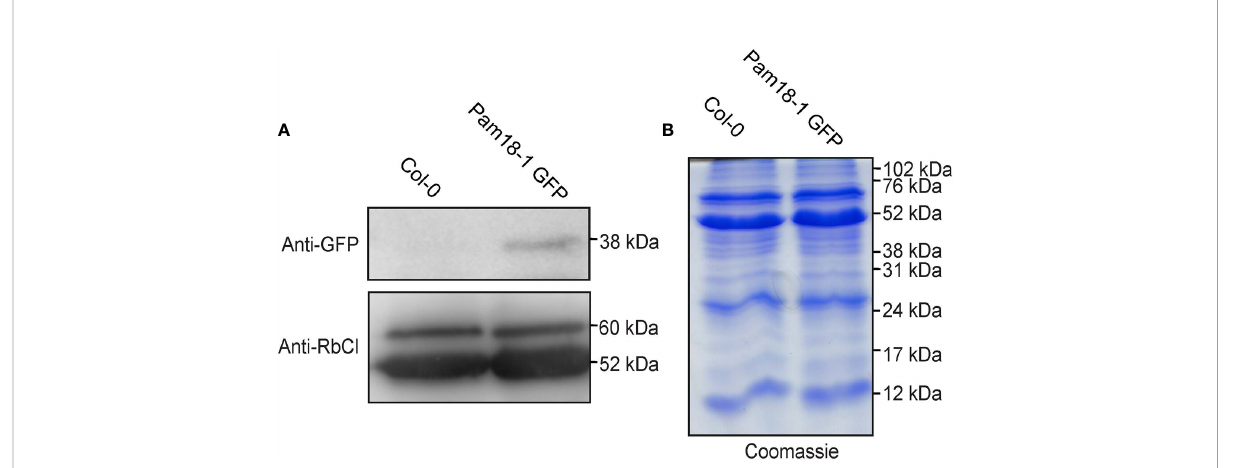
FIGURE 7 Immunodetection of Pam18-1 GFP under the expression of its endogenous promoter in isolated plastids. (A) Chloroplasts were isolated from 2 weeks old seedlings and immunodetected with anti-GFP and anti-RbCl. (B) Coomassie staining con fi rms equal protein loading and